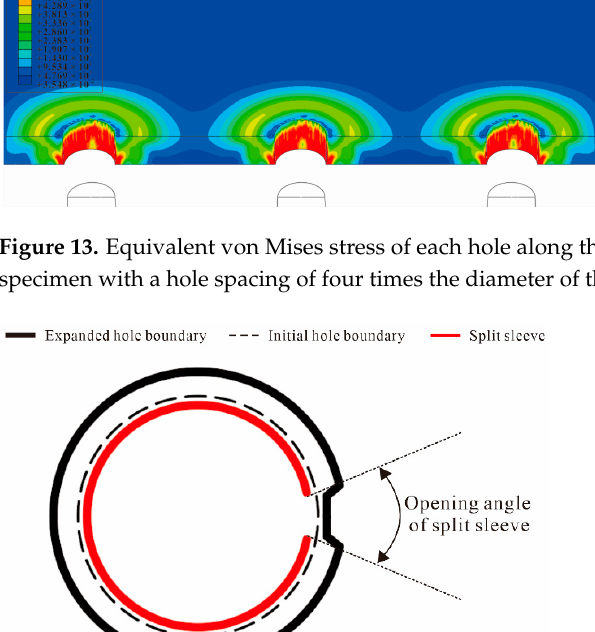
Figure 14. Schematic diagram of the influence of opening on the deformation during the extrusion of split sleeve (the opening angle is drawn at an arbitrary